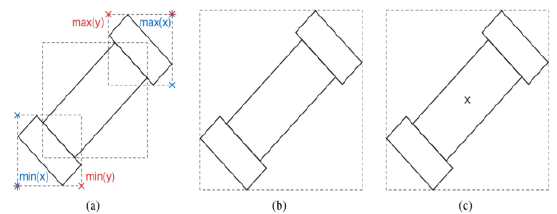
Figure 5: Simplified 2D example showing the steps for calculating the centroid of the bounding boxes for multiple related buildings. Dashed lines represent the bounding boxes, solid lines the buildings. First the minimum and maximum x and y values are chosen (a), next the joint bounding box is created (b), finally the center is calculated